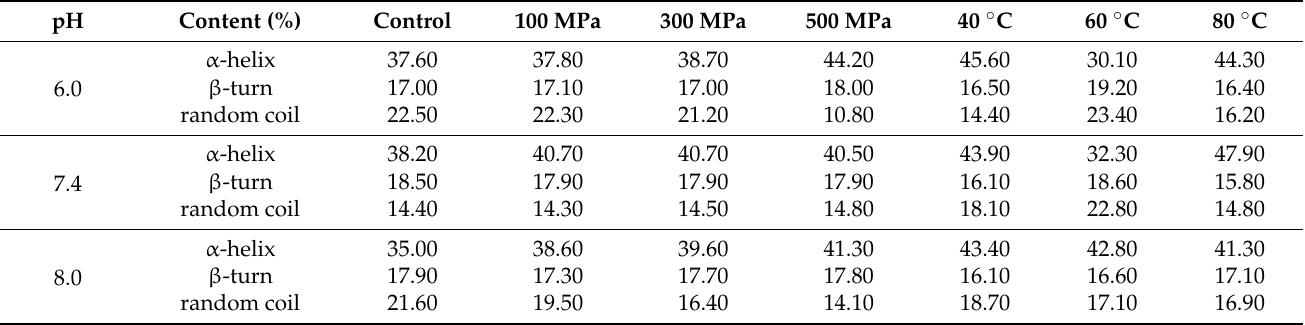
Table 2. The second structure content of α -lactalbumin at different treatments.